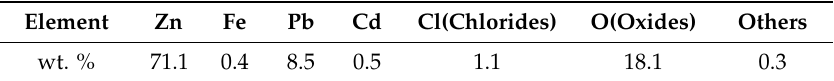
Table 7. Material balance of the melting process.